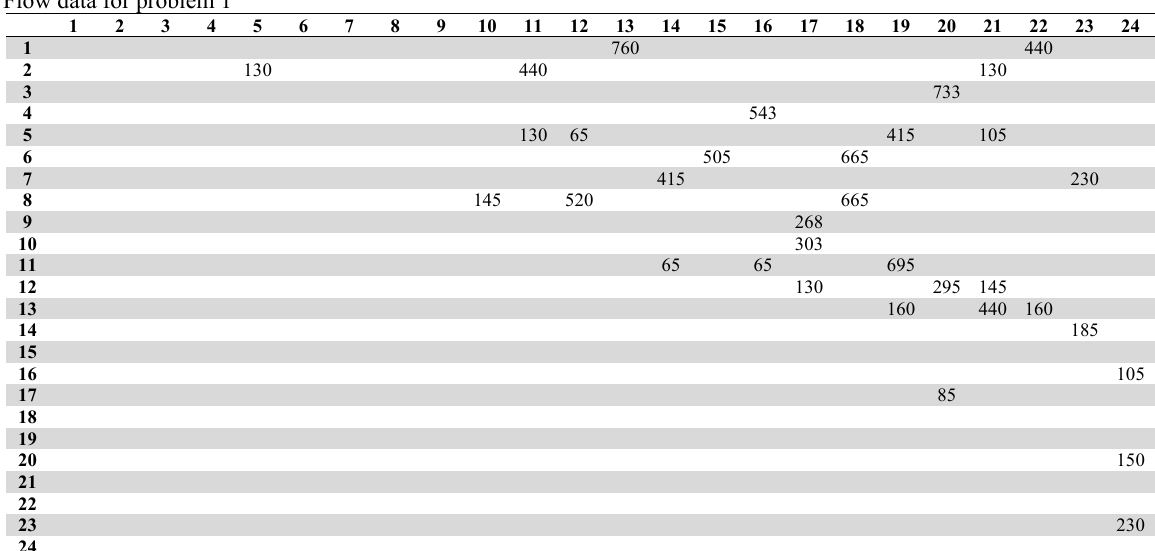
Flow data for problem